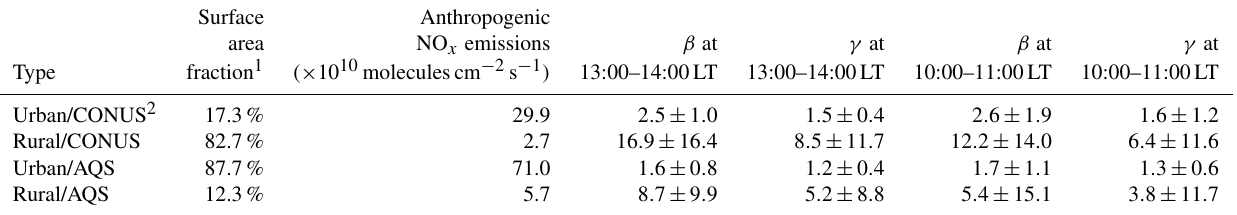
Table 2. Properties of urban and rural regions in July 2011.